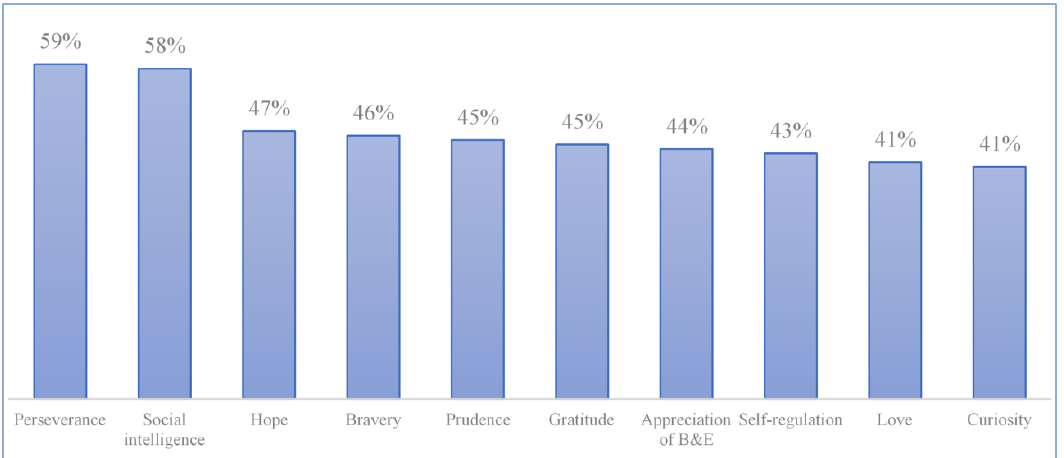
Figure 2. Top 10 Character Strengths Prioritized by NTCA Youth in Consultation